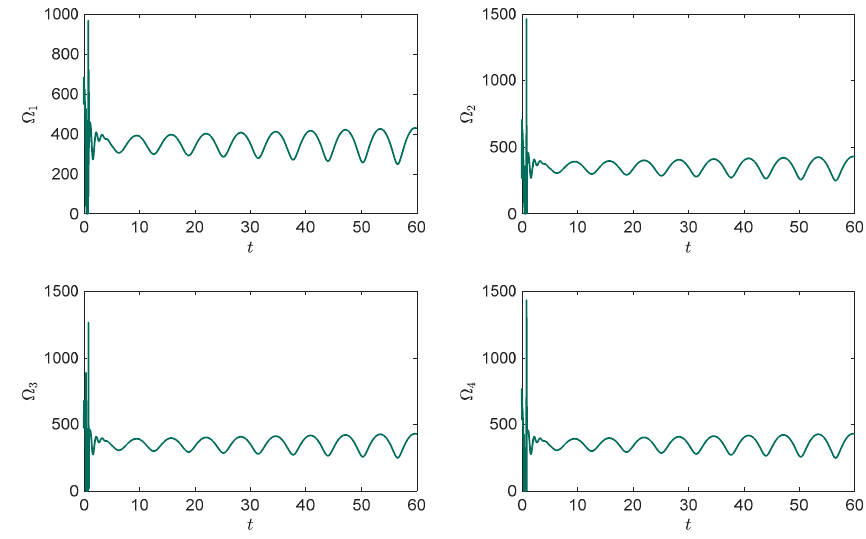
Figure 7. Rotor’s speed under the proposed control plan.